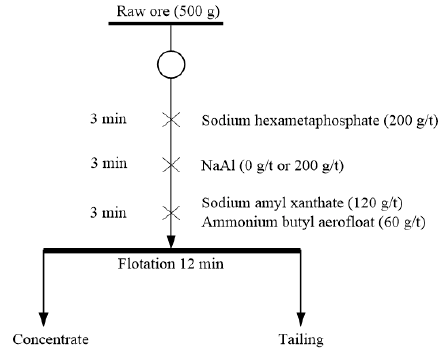
Figure 3. The beneficiation flow sheet of real ore experiments.